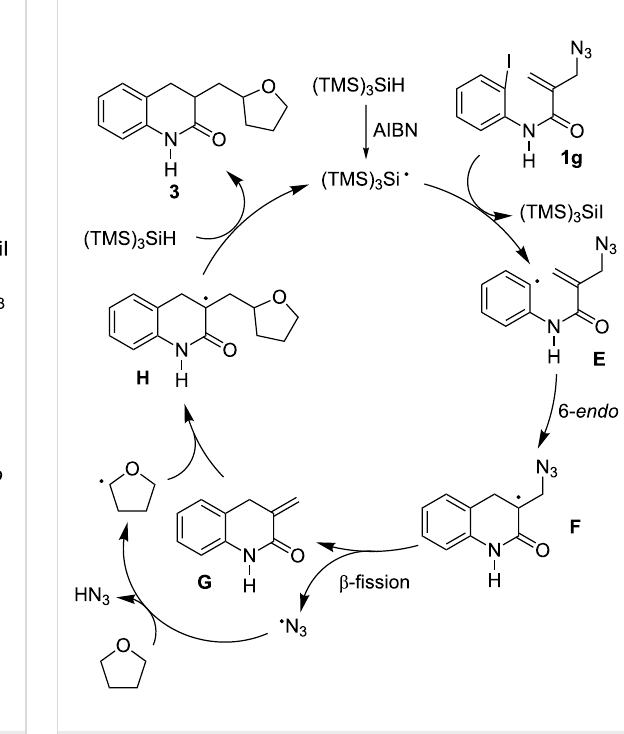
Scheme 6: Proposed mechanism for the formation of THF-incorpor- ating product 3 from 1g .